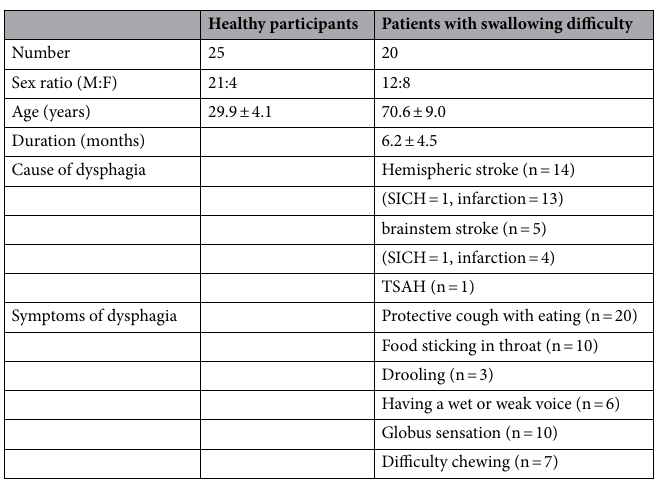
Table 1. Characteristics of participants. Mean ± standard deviation, M:F; male:female, TSAH; traumatic subarachnoid hemorrhage, SICH; spontaneous intra-cerebral